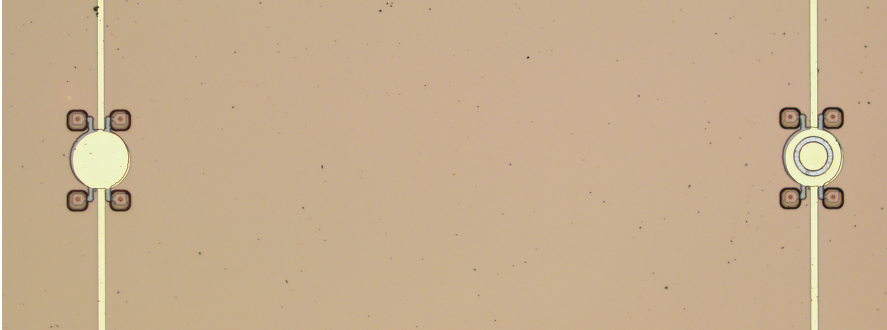
Figure 7. A uniform CMUT cell ( left ) and an embossed CMUT cell ( right